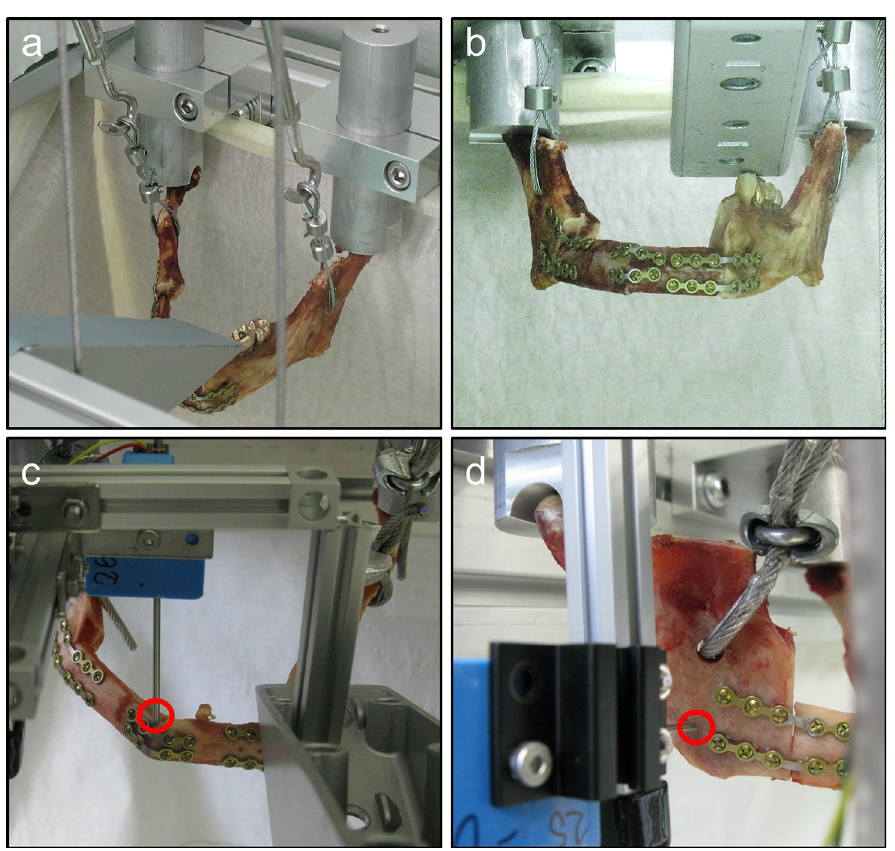
Fig 4. Biomechanical test setup for dynamic and static testing. (a) test setup for dynamic testing of the constructed specimen, force is applied through the cables fixed to the ramen mandibulae (b) front view of the dynamic test setup with an exemplary reconstruction using miniplates (c and d) static testing of the reconstruction in the same test rig as for dynamic testing with additional displacement sensors measuring (c) the vertical displacement on the mandible (red circle) at the contact plane of the fibula segments and (d) the lateral displacement at the ramen mandibulae.